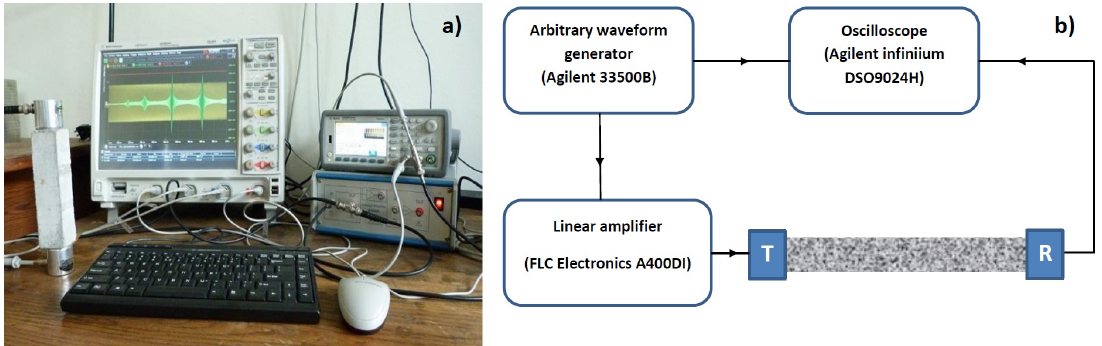
Figure 1. Experimental setup: ( a ) Photograph of the implemented configuration; ( b ) Sketch of the electronic